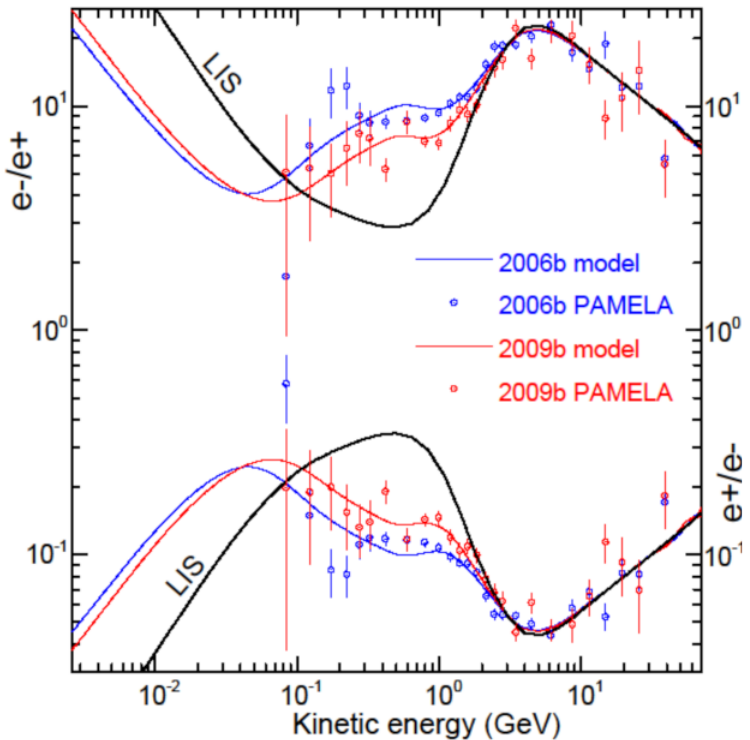
Figure 11. Ratio of electron to positron intensities ( e − /e + ) is shown as a function of kinetic energy (KE at Earth with respect to the ratio of the two respective VLIS (black lines) at 122 AU. In the lower part of the panel, the equivalent ( e + /e − ) is shown for illustrative purposes. Simulations are done for modulation conditions as in 2006b (blue lines) and 2009b (red lines) in comparison with PAMELA observations [2,82,113] during this solar minimum A < 0 drift